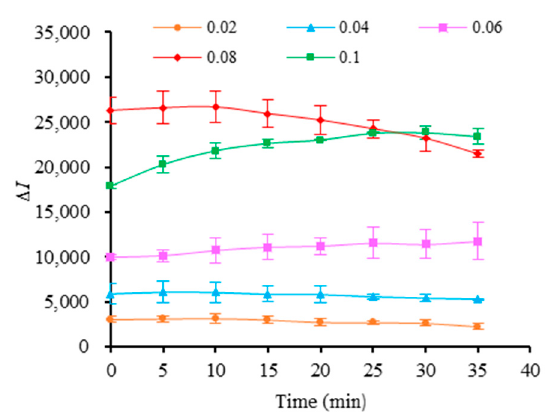
Figure 4. The fluorescence intensity changes in different concentrations of MB3 reacting with Hg 2+ .